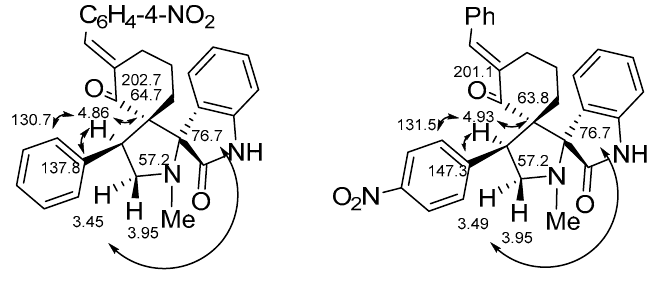
Figure 2. The key HMBC correlation for 2 and 3c .